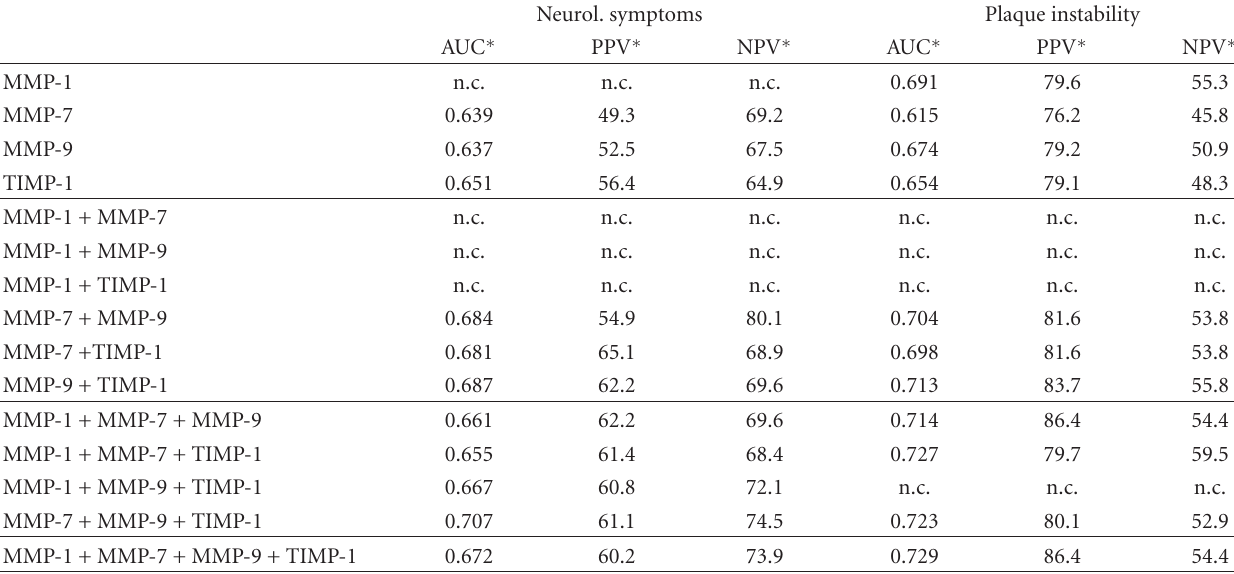
∗ AUC: area under curve; only values with statistical significance are shown; n.c.: no further increase in positive (PPV) and negative (NPV) predictive